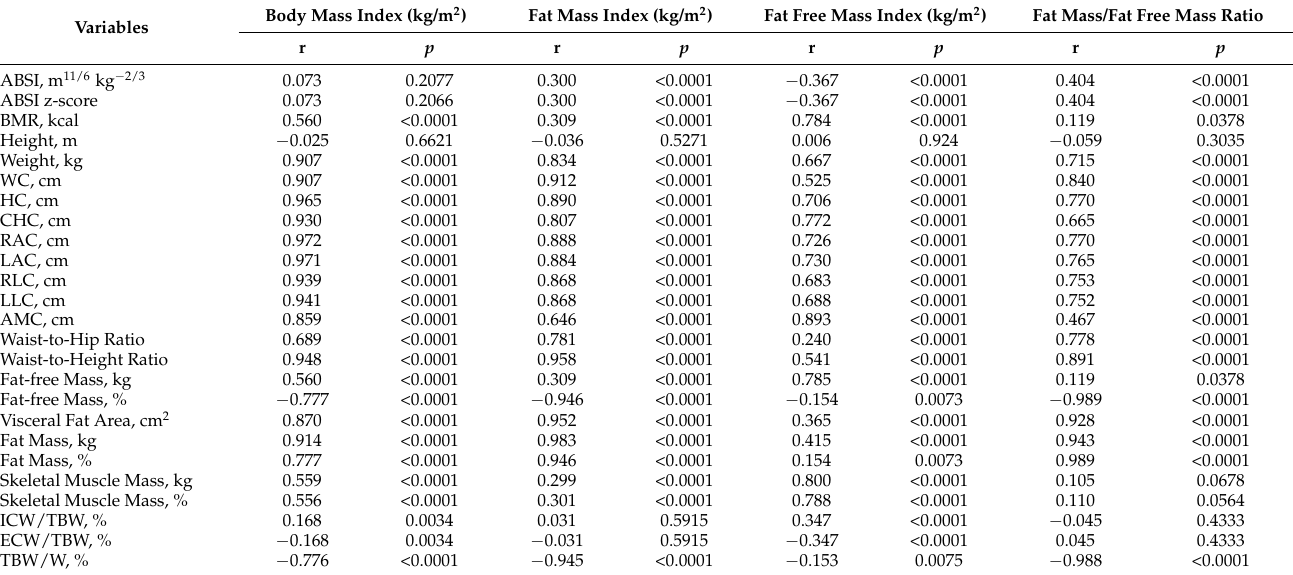
Table 2. Correlation between indices determining obesity and anthropometric parameters.